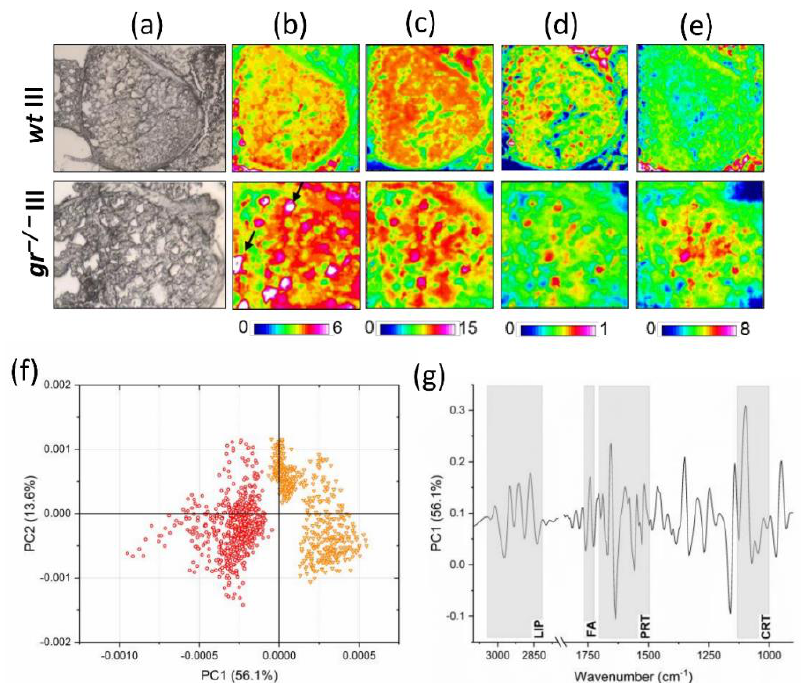
Figure 3. Infrared imaging analysis. ( a ) Microphotographs of class III oocytes in wt and gr − / − ovary sections. False color images showing the topographical distribution of: ( b ) lipids (color scale 0–6), ( c ) proteins (color scale 0–15), ( d ) glycosylated compounds (color scale 0–1), and ( e ) cortisol (color scale 0–8) (the dimensions of false color images were 328 × 328 mm). ( f ) Principal component analysis (PCA) scores’ plot of wt III (orange) and gr − / − (red) spectral data. ( g ) PC1 loadings of wt and gr − / − class III oocytes.